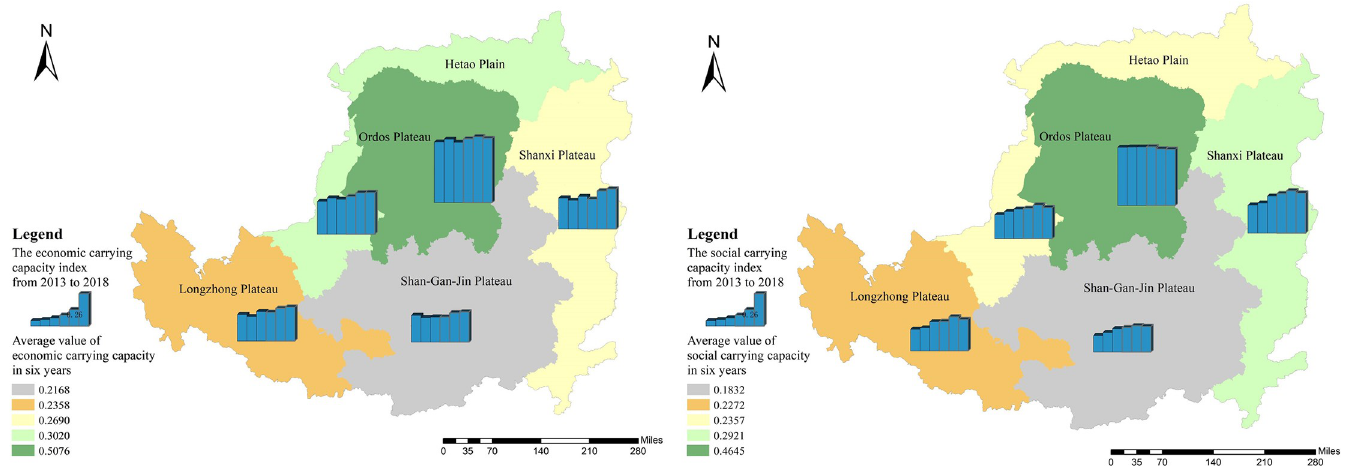
Fig 8. Temporal and spatial pattern of carrying capacity (left: economic carrying capacity; right: social carrying capacity). The image was obtained by using ArcGIS 10.2 through the open-access data process. The spatial extent of the Loess Plateau was obtained from the Resource and Environmental Science Data Center of the Chinese Academy of Sciences